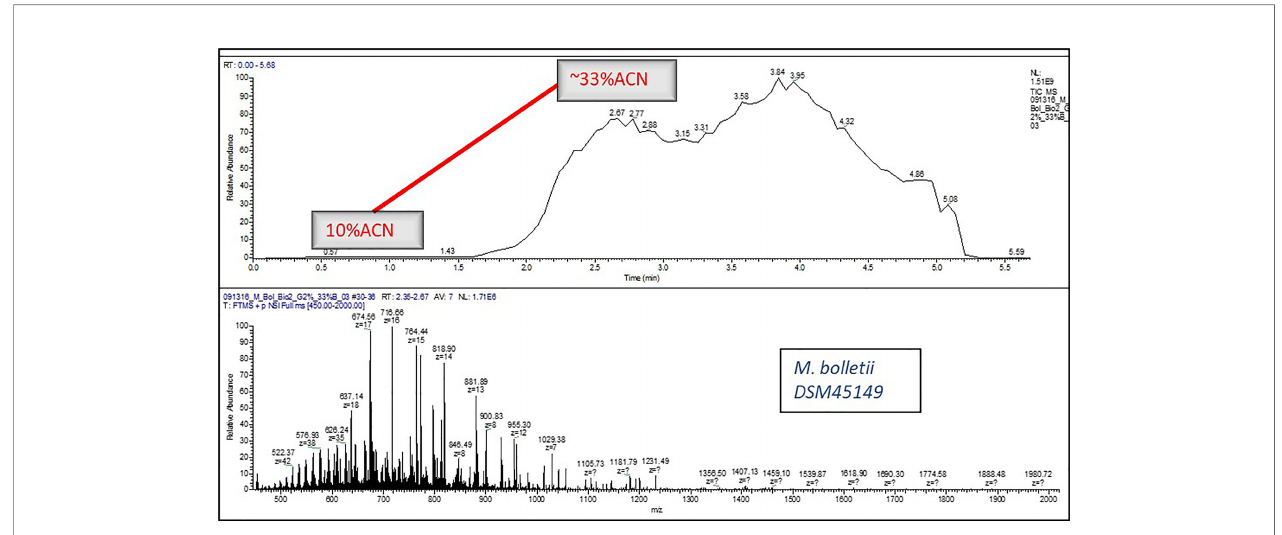
FIGURE 2 | A typical LC-MS chromatogram of Gradient Elution for e.g., Mycobacteroides bolletii DSM45149 .